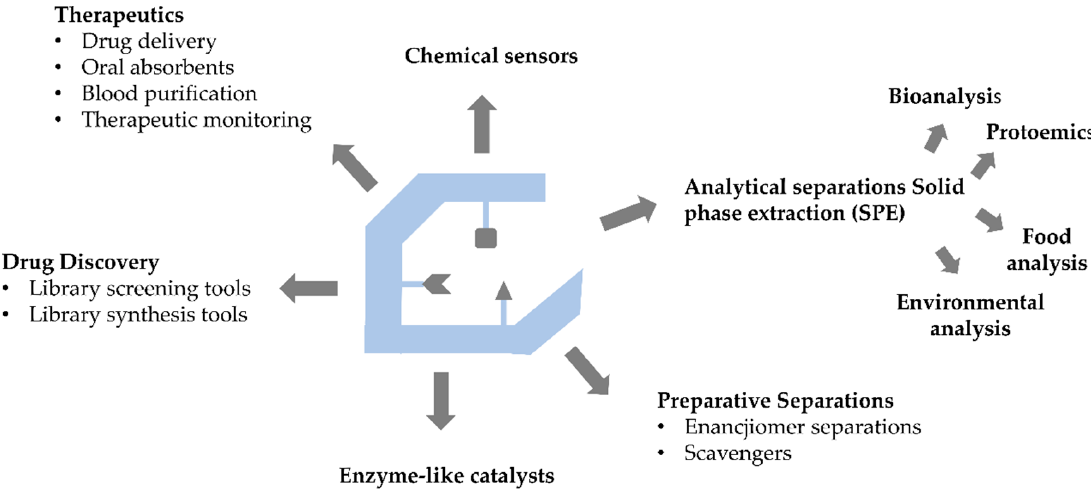
Figure 3. Scheme of the main applications for